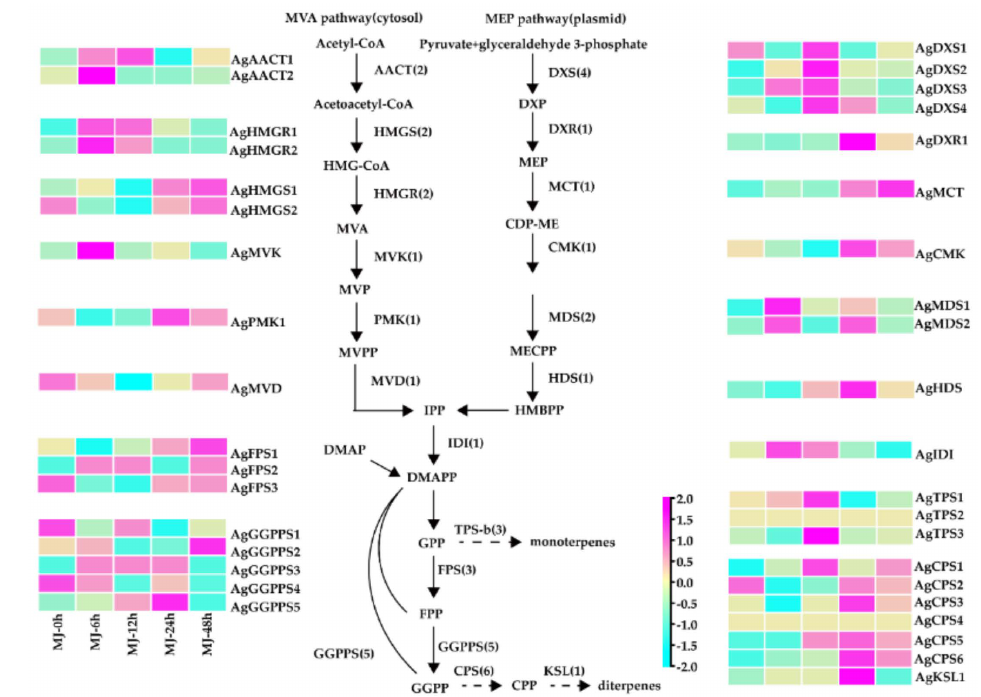
Figure 3. The expression profile for the genes involved in terpenoid biosynthesis in the root of A. gymnandrum . The transcriptome expression of each identified gene is Log2 normalization of fpkm values. Abbreviations: AACT, aceto-acetyl-CoA thiolase; CMK, 4-(cytidine 50-diphospho)- 2-C-methyl-D-erythritol kinase; DXS, 1-deoxy-D-xylulose 5-phosphate synthase; DXR, 1-deoxy-D- xylulose-5-phosphate reductoisomerase; FPS, farnesyl pyrophosphate synthase; HDR, (E)-4-hydroxy- 3-methylbut-2-enyl diphosphate reductase; HDS, (E)-4-hydroxy-3-methylbut-2-enyl diphosphate synthase; HMGS, 3-hydroxy-3-methylglutaryl-CoA synthase; HMGR, 3-hydroxy-3-methylglutaryl- CoA reductase; GGPPS, geranylgeranyl pyrophosphate synthase; MCT, 2-C-methyl-D-erythritol 4-phosphate cytidylyltransferase; IDI, isopentenyl diphosphate isomerase; MDS, 2-C-methyl-D- erythritol 2,4-cyclodiphosphate synthase; MDD, mevalonate diphosphate decarboxylase; MDS, 2-C-methyl-D-erythritol 2,4-cyclodiphosphate synthase; MVK, mevalonate kinase; PMK, phospho- mevalonate kinase; TPS, terpene synthases (including monoterpene synthases and sesquiterpene synthases); CPS, copalyl diphosphate synthase; KSL, kaurene